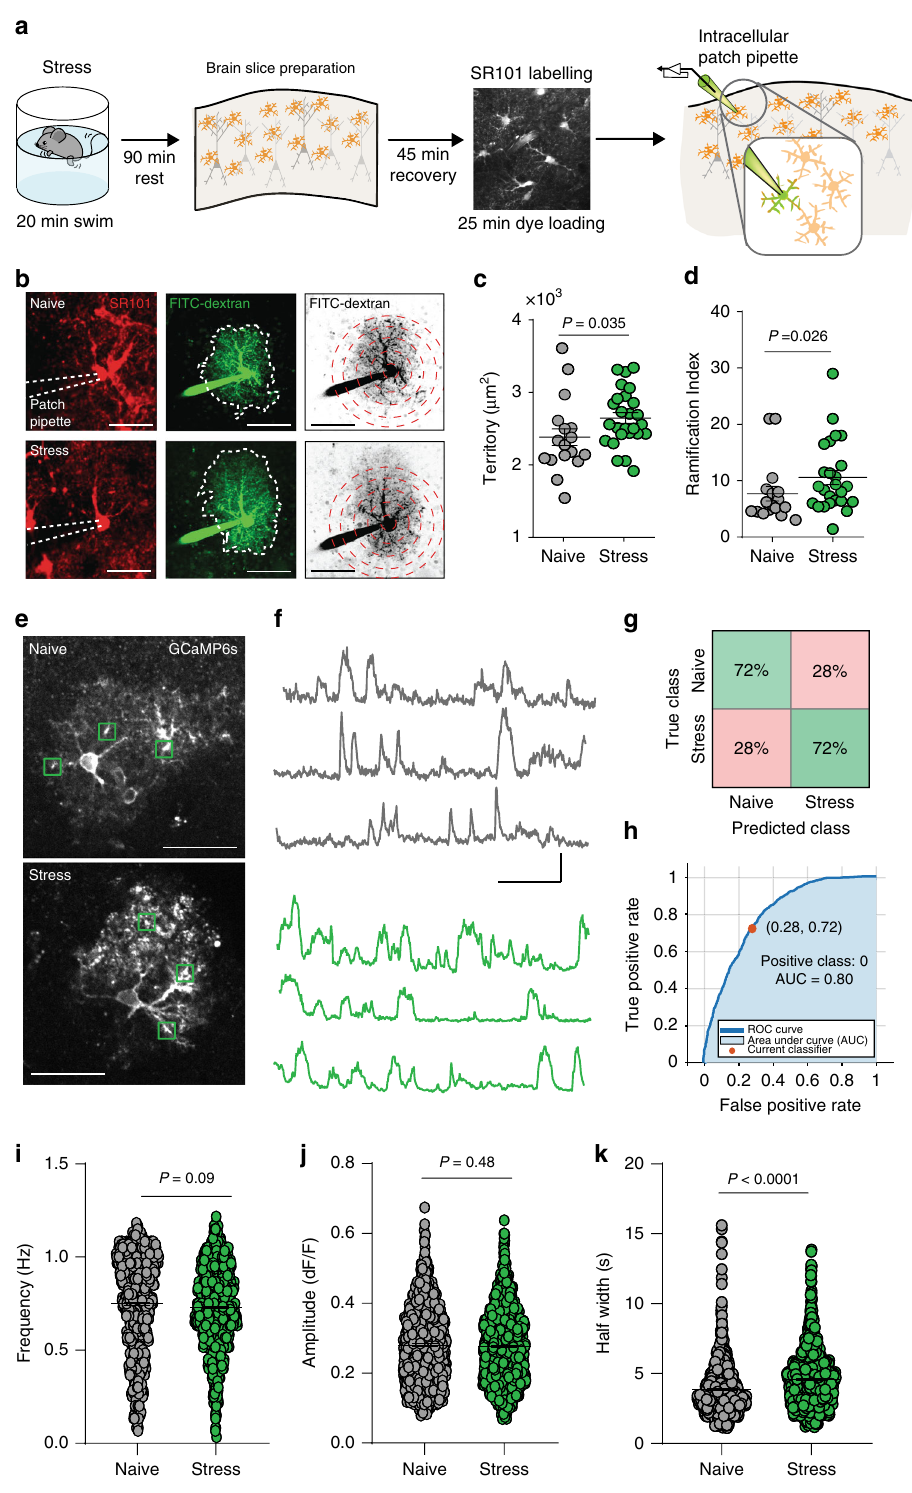
Fig. 2 Acute stress causes astrocyte hypertrophy and prolongs spontaneous calcium events in astrocyte microdomains. a Timeline of experimental procedure. b Z-stack projection of SR101 labeled astrocytes (left), which were patched and fi lled with 3 – 5 kDa FITC-dextran (middle), for morphological analysis (right). Scale bar: 20 µ m. c Comparison on territory sizes of individual astrocytes from naïve and stressed mice. Naïve: n = 5 mice, n = 17 cells. Stress: n = 6 mice, n = 26 cells. Error bars: mean ± s.e.m. Mann – Whitney U -test. d Comparison of astrocyte rami fi cation in naïve and stress conditions. Error bars: mean ± s.e.m. Mann – Whitney U -test. e Representative images of GCaMP6s expression in neocortical astrocytes from naïve (top) and stressed (bottom) mice. Scale bar 35 µ m. f Representative raw traces of microdomain calcium from naïve (top, gray) and stressed mice (bottom, green). Scale bars 2.5dF/F and 2 min. g , h Accuracy of classi fi er in distinguishing naïve from stressed calcium traces. i , k Scatter dot plots comparing frequency ( i ), amplitude ( j ), and half-width ( k ), of individual microdomain calcium events between naïve ( n = 904 microdomains) and stressed ( n = 1135 microdomains) groups. Unpaired t